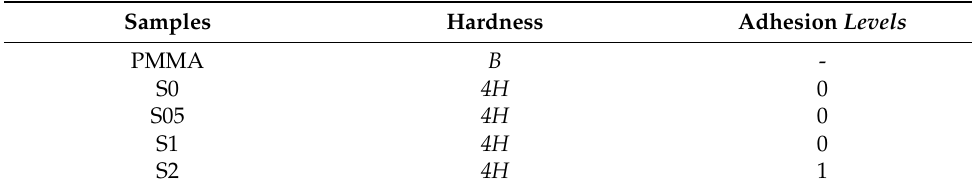
Table 2. Hardness and adhesion levels of PMMA and